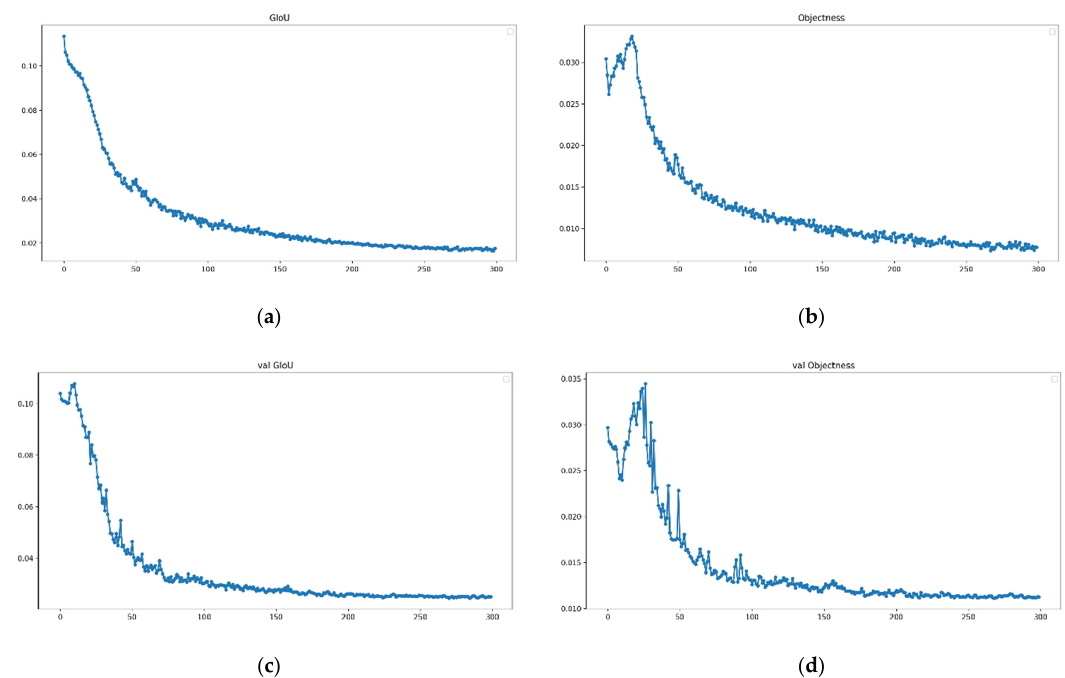
Remote Sens. 2021 , 13 , 3691 Figure 6. Numerical variation diagram of loss values in the YOLOv5 training process. The GIoU loss value curve in training dataset ( a ) and validation dataset ( c ); Target detection loss mean curve in training dataset ( b ) and validation dataset ( d ).